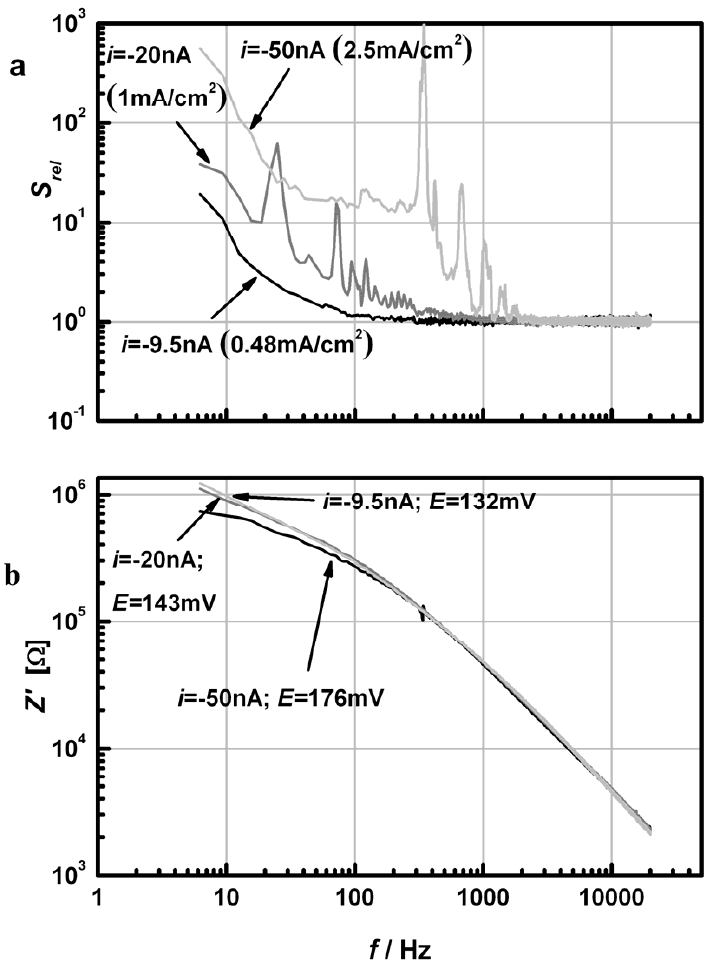
Fig. 3 Relative power spectral density ( a ) and real part of impedance ( b ) measured on d = 50 μ m Ag microelectrode in a 0.5 M H 2 SO 4 aqueous solution for three different external